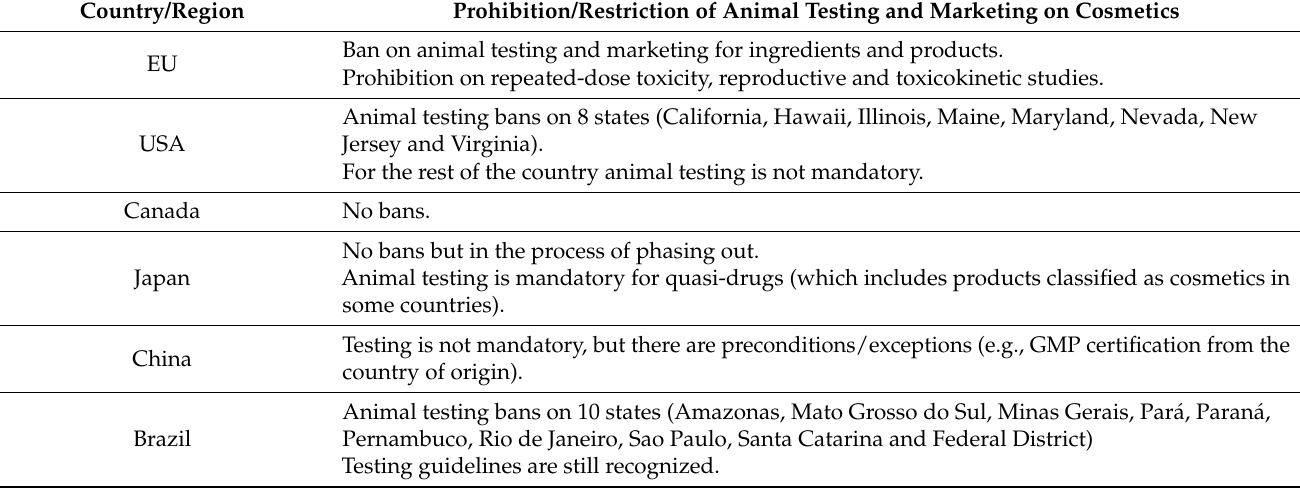
Table 5. Current prohibitions and/or restrictions in force regarding cosmetic animal testing and marketing, by country or